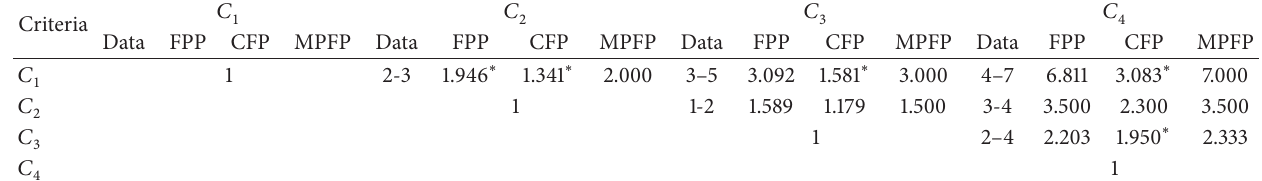
Table 4: Solution matrix of criteria for FPP, CFP, and MPFP methods (Example 1).